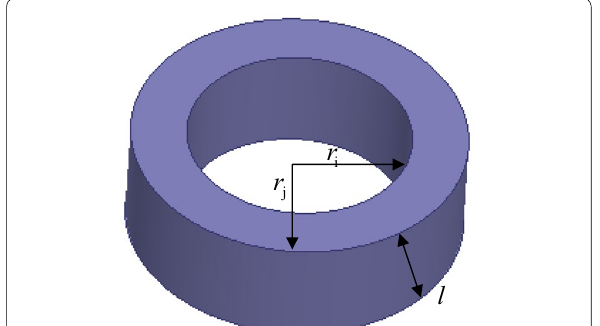
Figure 3 Rotor lamination of PMBMB